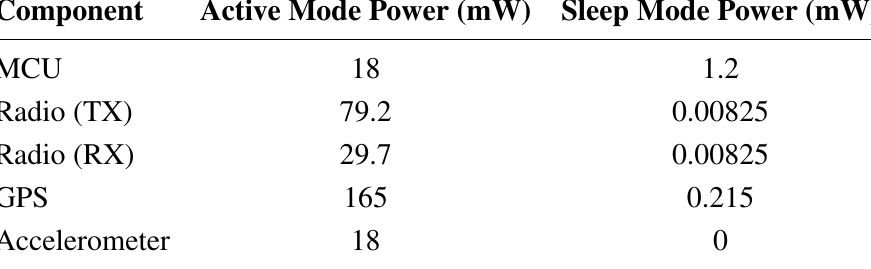
Table 1. Active and sleep mode power consumption for node